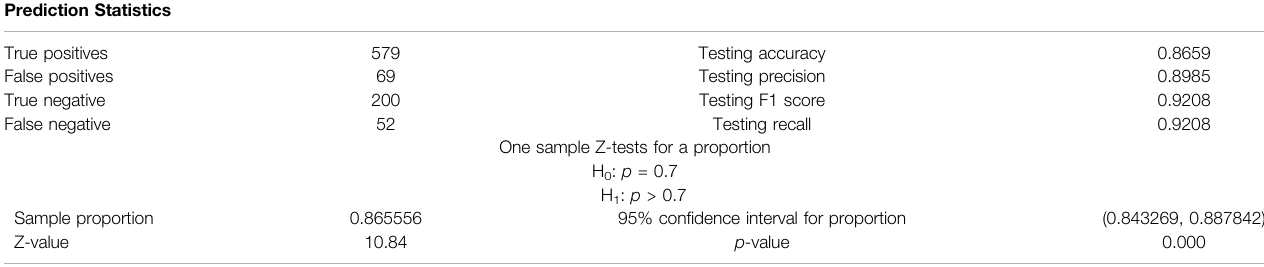
TABLE 3 | Prediction metrics and hypothesis test of RNN model for classifying OCRs that mention product defects from OCRs that do not mention product defects. Prediction Statistics